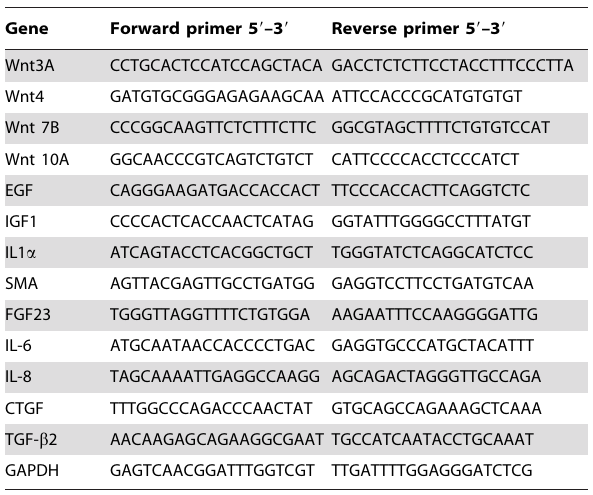
Table 1. Primers used in